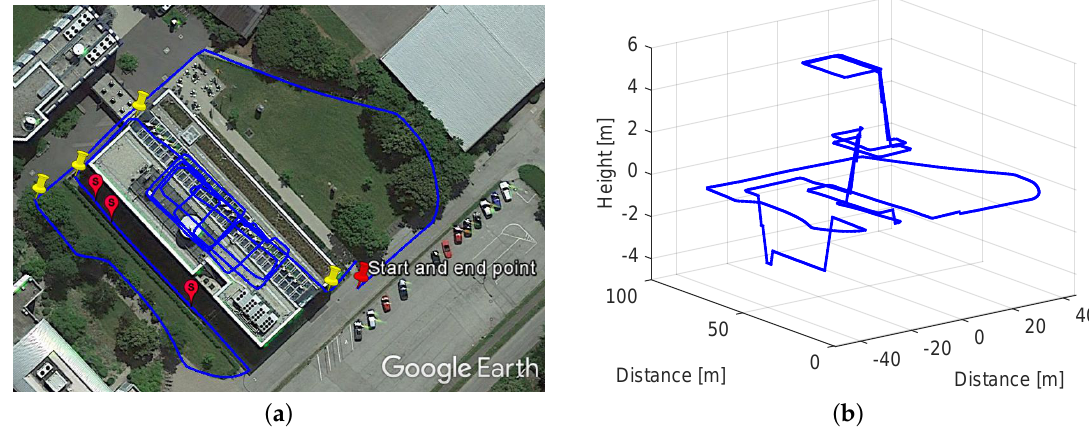
Figure 10. ( a ) shows the trajectory computed with the quasi-error-free measurements. The red pin highlights the start and end point, the yellow pins the detected outdoor corners and the pink placemarks the detected outdoor stairs. ( b ) shows the three dimensional view of the computed trajectory.